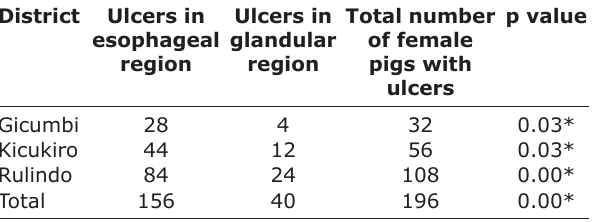
Table-5: Occurrence of esophageal and glandular gastric ulcers in slaughtered female pigs according to district. District